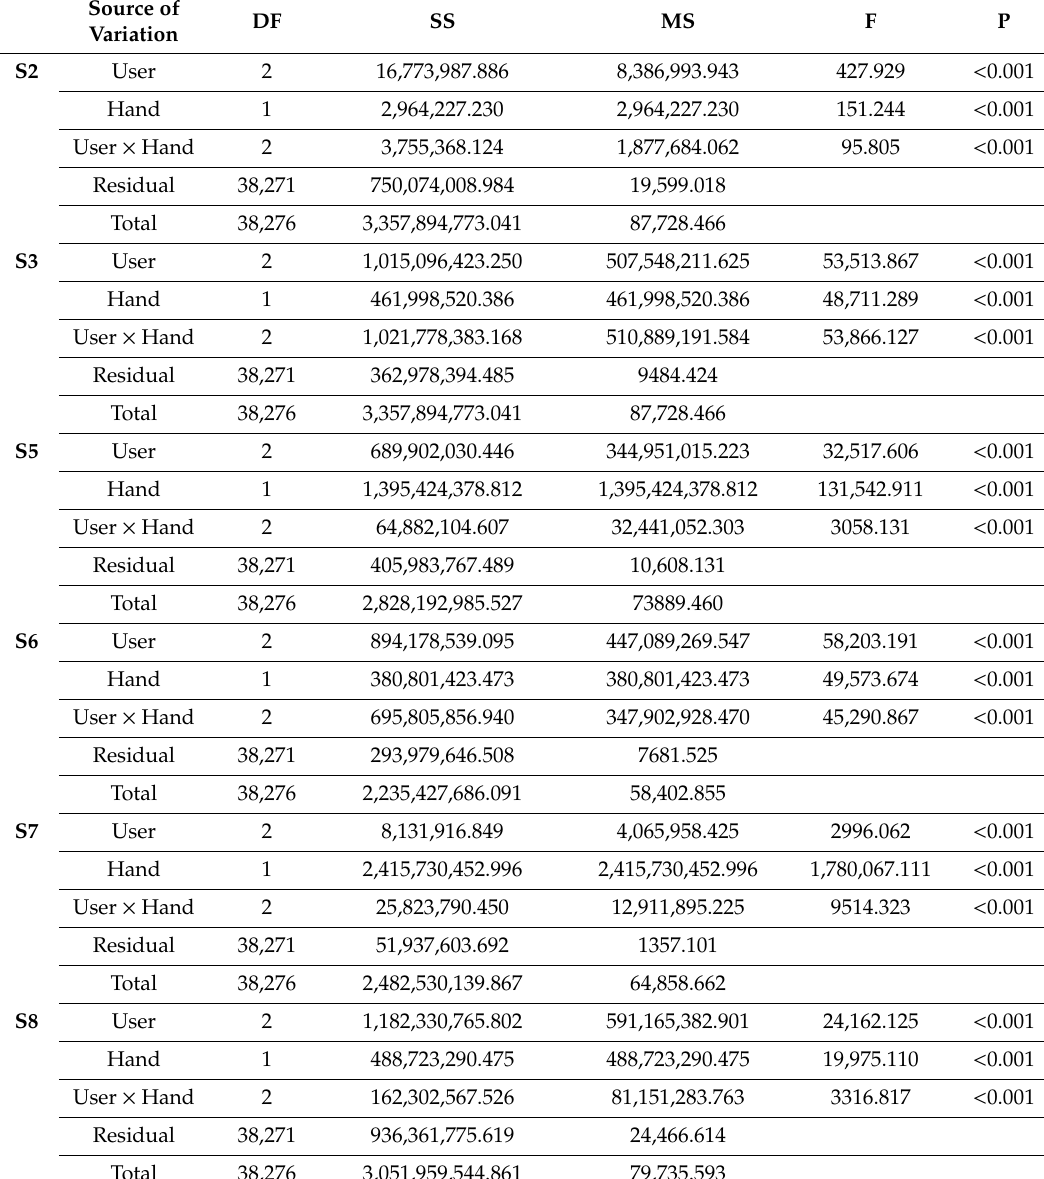
Table 2. Results from 2-way ANOVA (general linear model) on individual sensor data as a function of user and